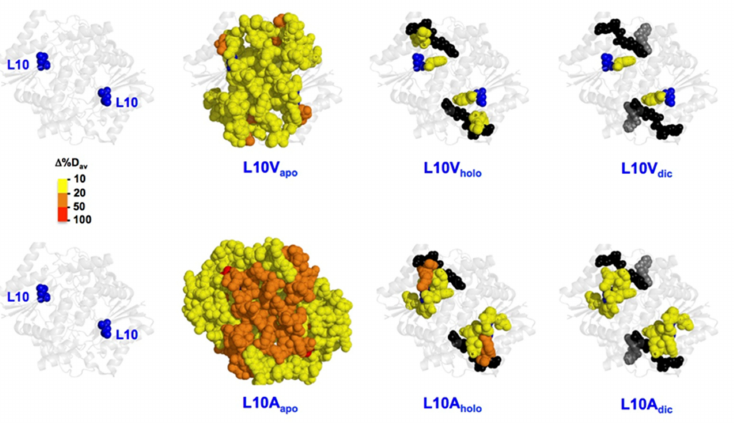
Figure 7. Representation of the changes in local stability (as ∆ %D av ) due to mutations L10V and L10A vs. WT. Results are shown as indicated in the color scale for different ligation states (NQO1 apo , NQO1 holo and NQO1 dic ). FAD and Dic are shown as spheres (black and grey, respectively). The structural model used for display was PDB 2F1O